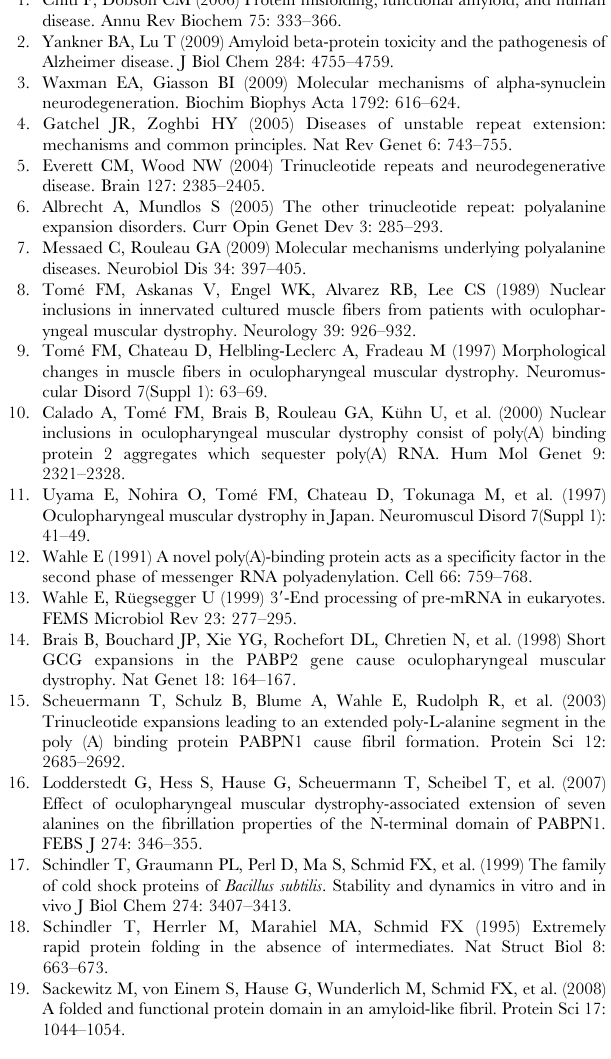
are shown with filled; variants with 17 alanines with open symbols; variants with linkers of 3 amino acids are shown as circles; variants with linkers of 16 amino acids as triangles. Measurements were Transitions of the fusions with CspB, B Transitions of the fusions with MCspB. Figure S3 Comparison of ANS and ThT fluorescence signals of 17Ala-L16-CspB during fibril formation. Filled symbols correspond to ThT, open symbols to ANS signals. Figure S4 ANS fluorescence of fusion proteins without alanines. The fusions were incubated at concentrations of